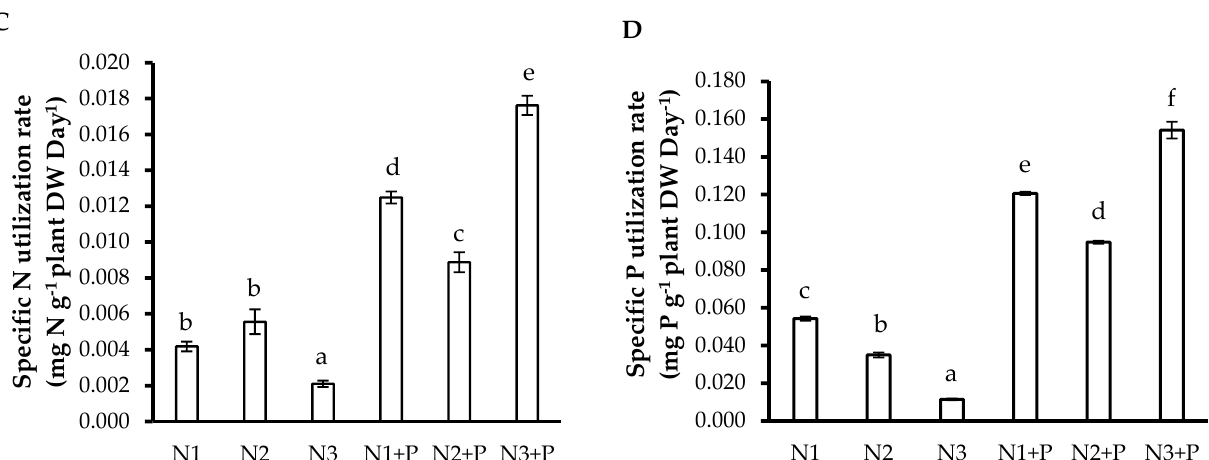
Figure 2. ( A ) Specific N assimilation rate (mg N g − 1 root DW day − 1 ); ( B ) Specific P assimilation rate (mg P g − 1 root DW day − 1 ) ; ( C ) Specific N utilization rate (mg N g − 1 plant DW day − 1 ) ; ( D ) Specific P utilization rate (mg P g − 1 plant DW day − 1 ) of 180-day-old L. leucocephala saplings grown in Veld Fertilizer Trial soils from Ukulinga Experimental Farm, South Africa. Values represent the means ± SE, based on n = 5. Significant differences among treatments ( p < 0.05) are denoted by different superscript letters.